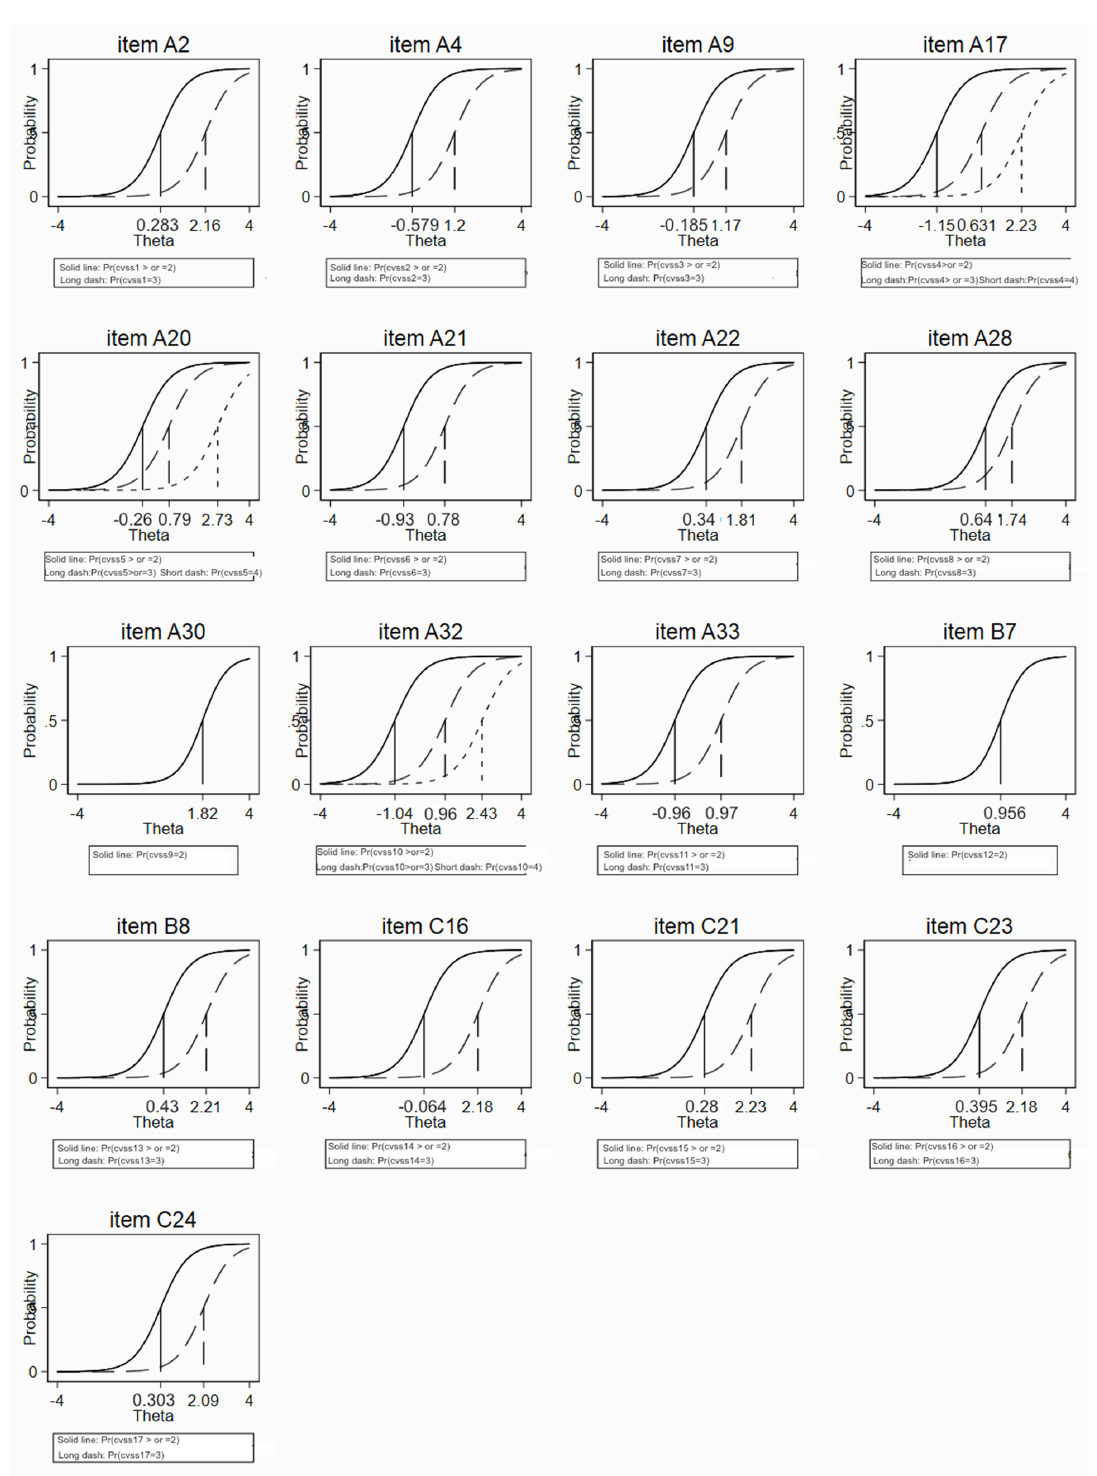
Figure 3. Boundary characteristic curves (BCC) from the graded response model (IRT analysis) of the Italian version of CVSS.